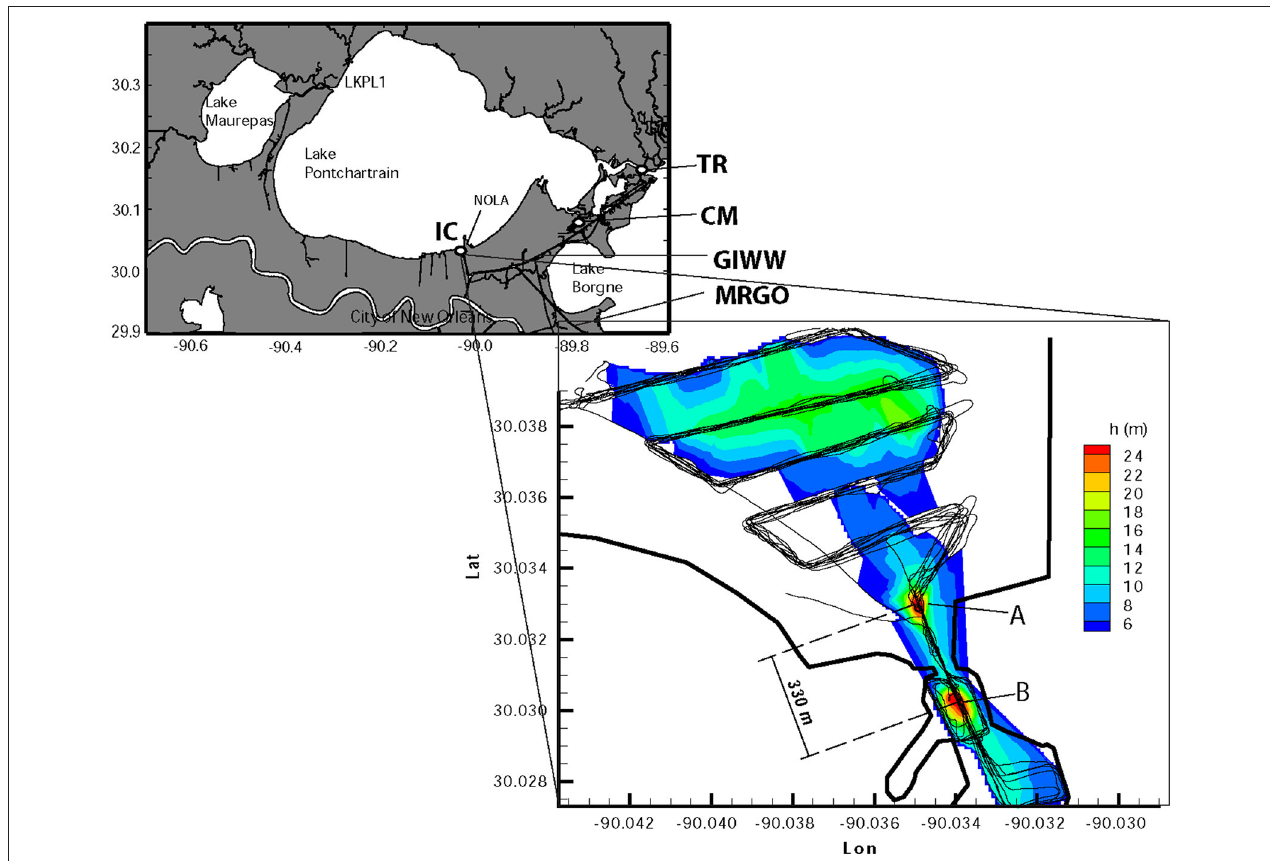
FIGURE 1 | Study area near the southern coast of the Lake Pontchartrain, and ADCP survey tracks (black lines) and bathymetry contours measured from the ADCP. The two scour holes, (A,B) , are shown by the red color deep waters, which separated by 330m. The thick black lines are the coastlines. The Rigolets, Chef Menteur, Industrial Canal, the Mississippi River Gulf Outlet, and the Gulf Intracoastal Waterway are indicated by TR, CM, IC, MRGO, and GIWW,